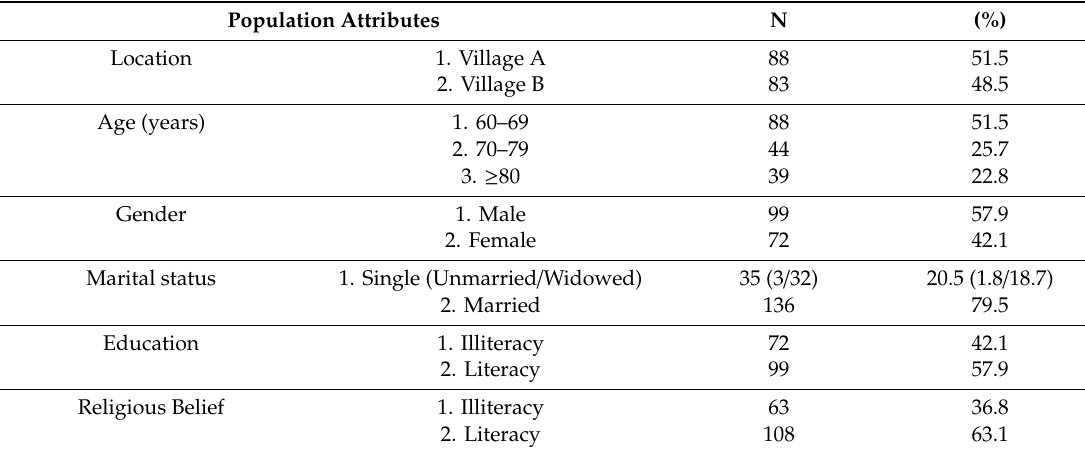
Table 1. Characteristics of the